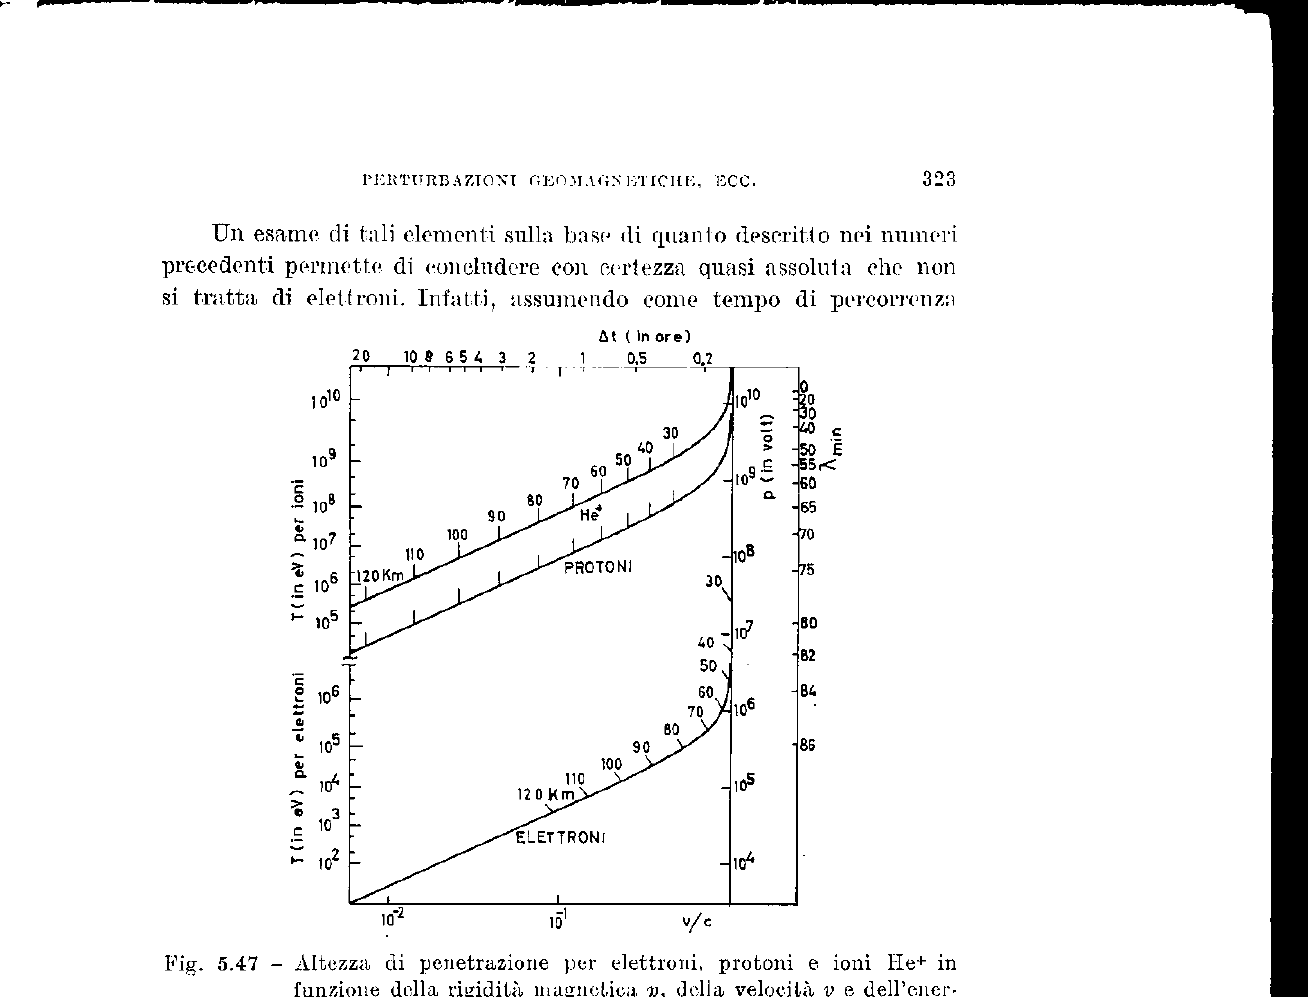
Fig. 5.47 - Altezza di penetrazione per elettroni, protoni e ioni Iie+ in funzione della rigidità magnetica p, della velocità v e dell'ener- gia cinetica T. Sulla scala di destra è riportata la latitudine geomagnetica minima A mln cui possono giungere le particelle di rigidità p-, sulla scala in alto tempo di transito At dal Sole alla Terra su percorso rettilineo (secondo